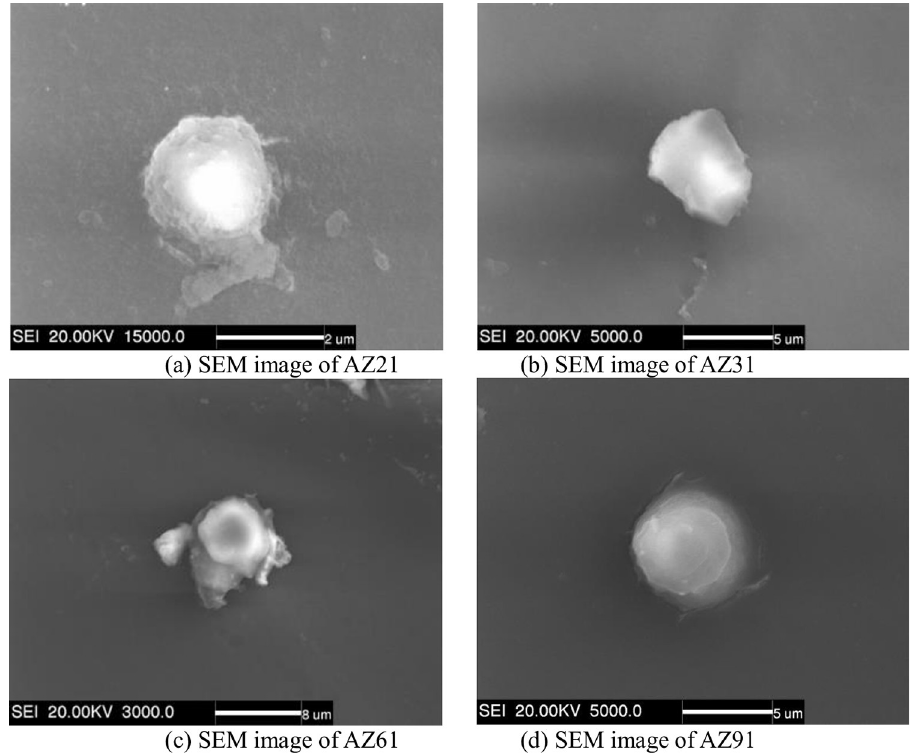
Fig 5. SEM image of Mg-Al alloys with added Al 4 C 3 . (a) SEM image of AZ21; (b) SEM image of AZ31; (c) SEM image of AZ61; (d) SEM image of AZ91.